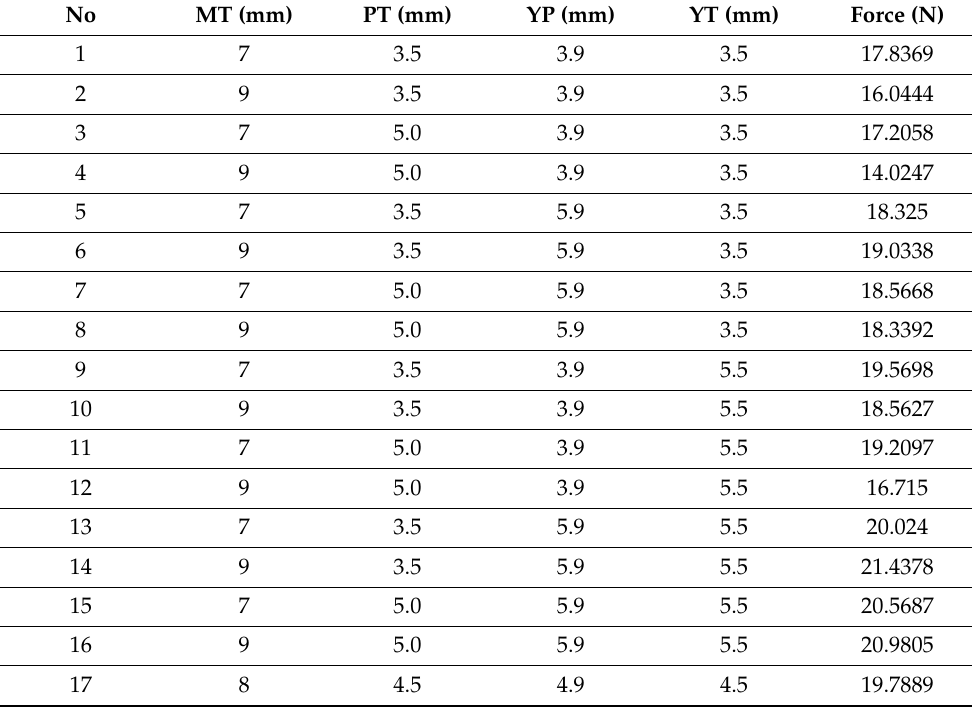
Table 3. Full factorial design matrix and results of vertical magnetized